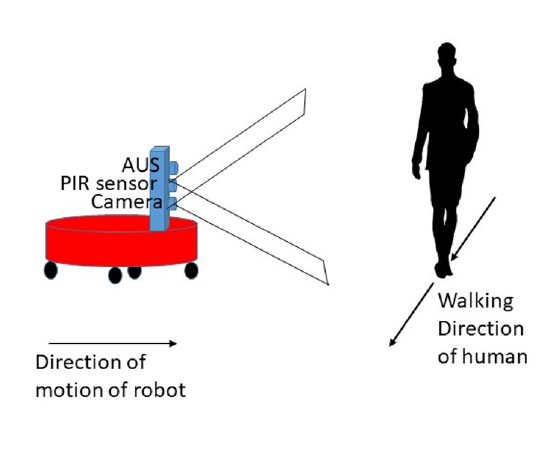
Figure 10. Direction of motion of the mobile robot and human being during experiment